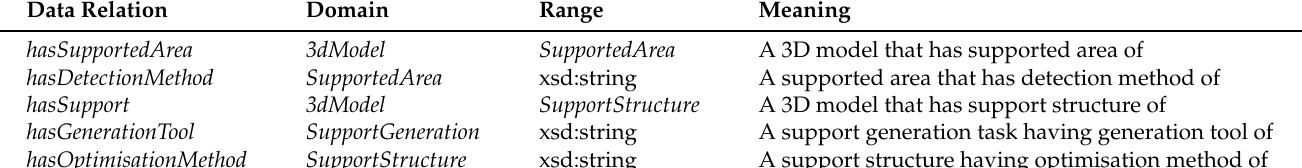
Table 5. Domain, range, and meaning of five relations in support generation.